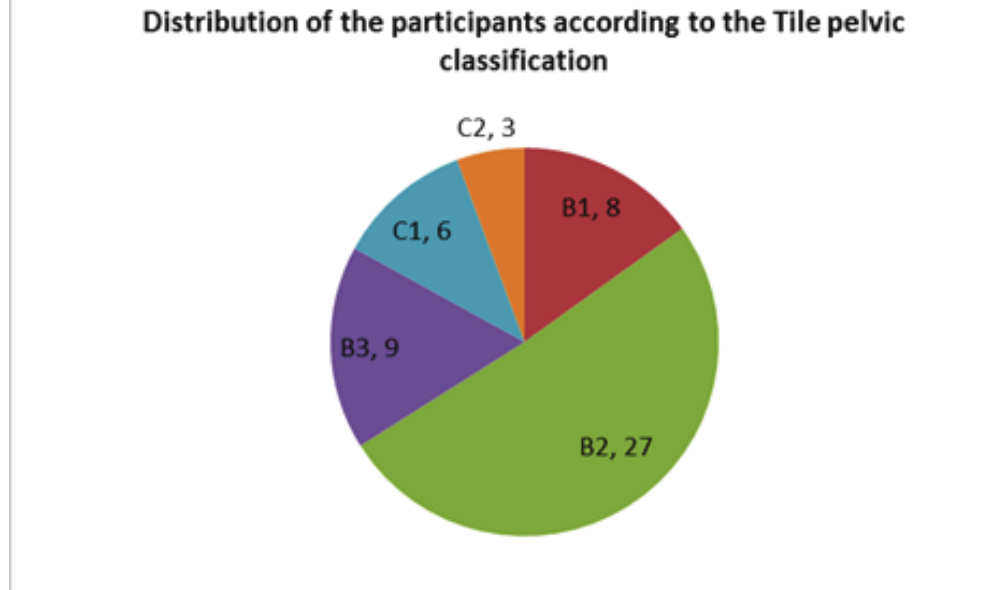
Figure 1: Distribution of the participants according to the Tile pelvic